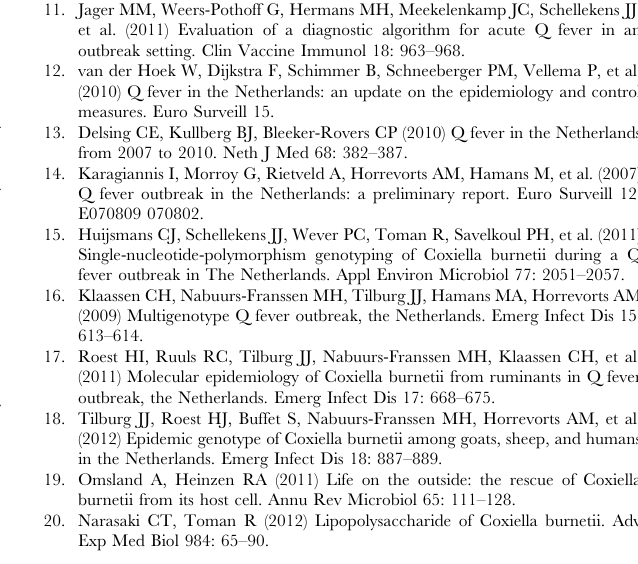
Table S1 Data on spleen weight (mg) and associated bacterial load (genome equivalent) obtained from indi- vidual mice for each of C. burnetii isolates used in this